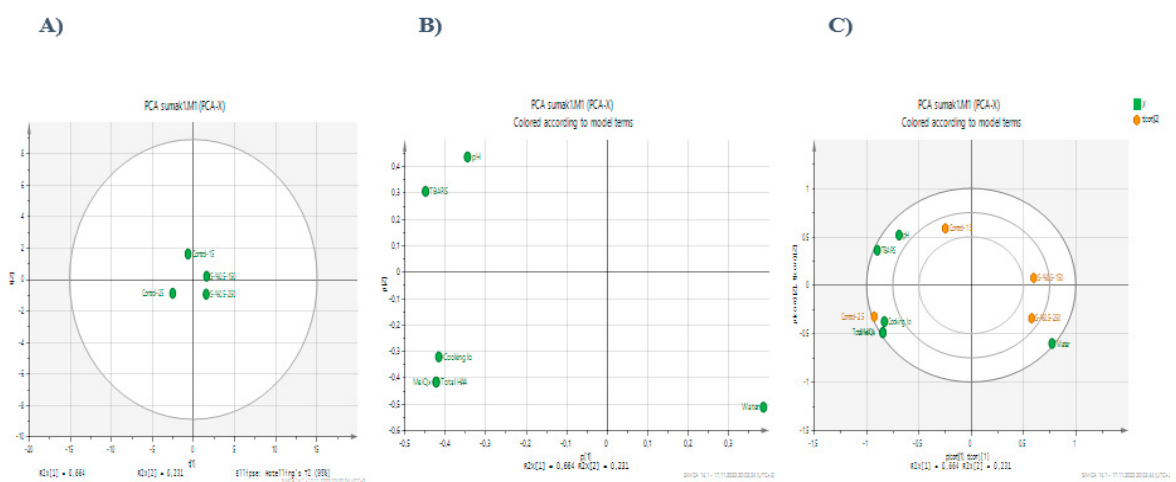
Figure 2. Score scatter plot ( A ), loading scatter plot ( B ), and biplot ( C ) of PCA analysis (PC1 versus PC2) for the components in the meatballs. C-150–250: control group meatballs cooked at 150, and 250 ◦ C, respectively. S-0.5–150–250: meatballs formulated with 0.5% sumac and cooked at 150, and 250 ◦ C,